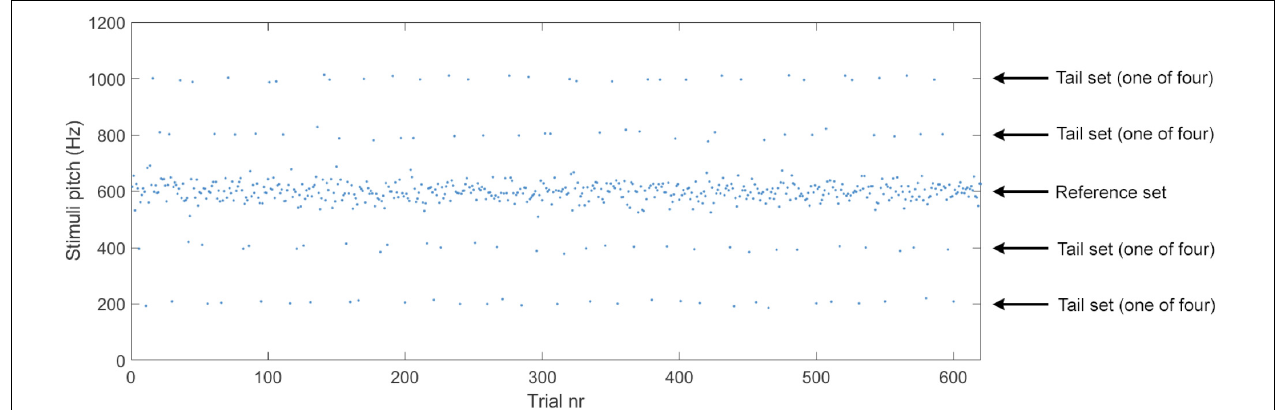
FIGURE 3 | Example of stimuli presentation in Experiments 1A and 1B with pitch as a function of trial. See main text for details regarding the properties of the reference set and tail